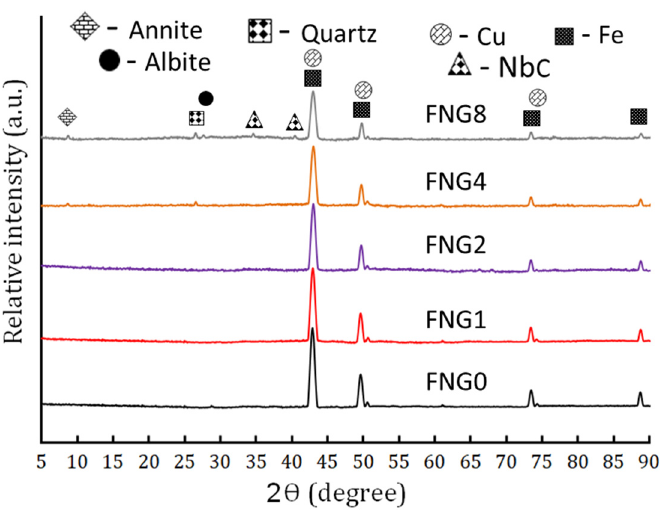
Figure 3. The XRD patterns of FNG0, FNG1, FNG2, FNG4 and FNG8 after 10 h of milling.